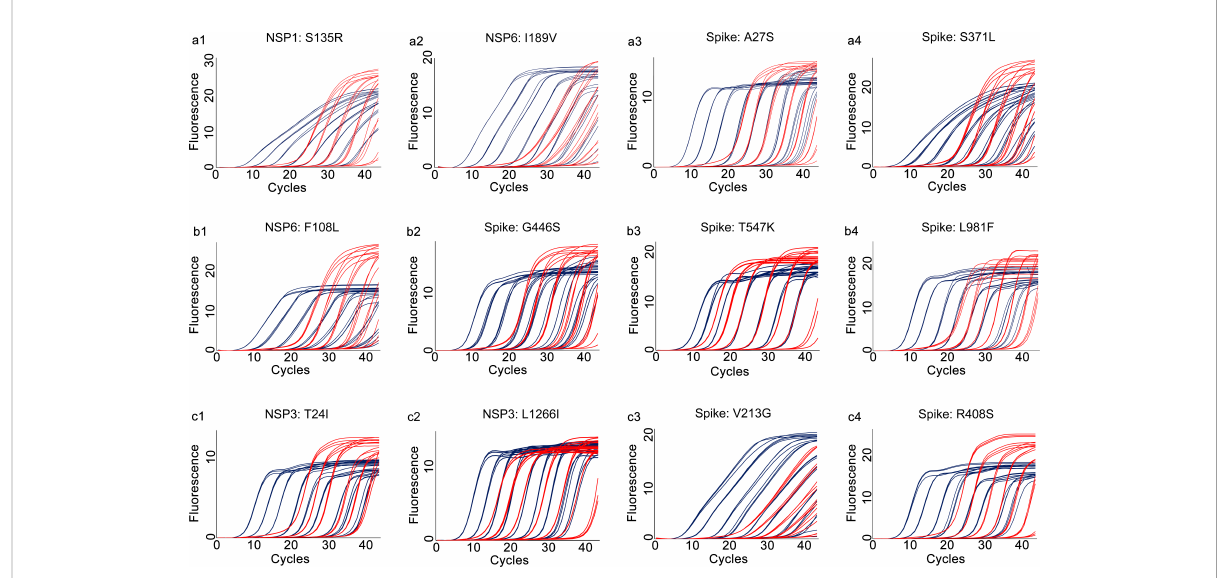
FIGURE 4 Ampli fi cation curves for the developed multiplex allele-speci fi c qRT-PCR assays against the prototype genes of SARS-CoV-2. The viral prototype genes (NSP1, NSP3, NSP6 and Spike) were in vitro transcribed and 10-fold diluted from 10 7 copies/reaction (2.33×10 7 , 4.45×10 7 , 3.10×10 7 , 6.82×10 7 for NSP1, NSP3, NSP6 and Spike, respectively) to 10 -1 copies/reaction. Two parallel reactions targeting the prototype allele and the mutated allele of the developed assays were performed by using the in vitro transcribed and serially diluted prototype RNA as template. The ampli fi cation curves for the prototype allele targeting reactions (in dark blue) were then merged with those of the corresponding mutated allele targeting reactions (in red). The ampli fi cation curves for assay 1 [NSP1: S135R (a1), NSP6: I189V (a2), Spike: A27S (a3), and Spike: S371L (a4)], assay 2 [NSP6: F108L (b1), Spike: G446S (b2), Spike: T547K (b3) and Spike: L981F (b4)], assay 3 [NSP3: T24I (c1), NSP3: L1266I (c2), Spike: V213G (c3), and Spike: R408S (c4)] are